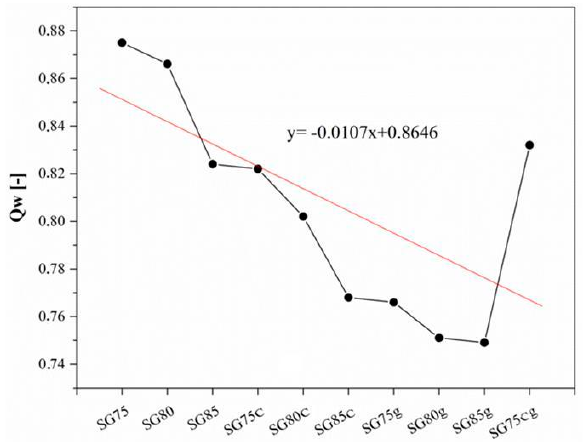
Figure 7. Effect of starch and glycerin content and of the addition of casein or gelatin as a modifier on equilibrium swelling in cellulose-starch composites.